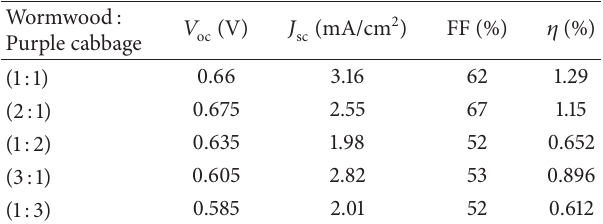
Figure 3: Absorption spectra of chlorophyll dye, anthocyanin dye, and cocktail dye. Table 2: Photoelectrical parameters of DSSCs sensitized by cocktail dyes at different volume